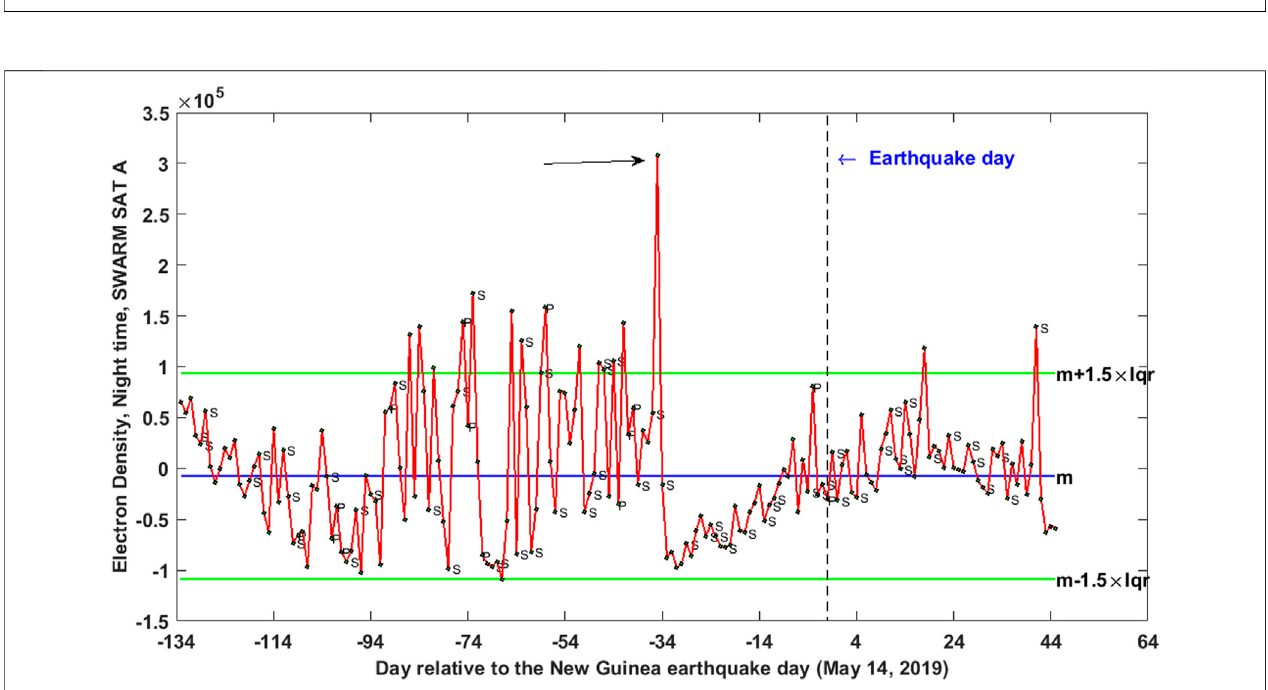
FIGURE8 | Results ofSwarm A electron density data analysisfor the New Guinea earthquake (May14, 2019) from January 01to June30, 2019 at night time. The symbols “ P ” and “ S ” indicate disturbed magnetic days ( “ P ” according to magnetic indices, “ S ” according to solar parameters).